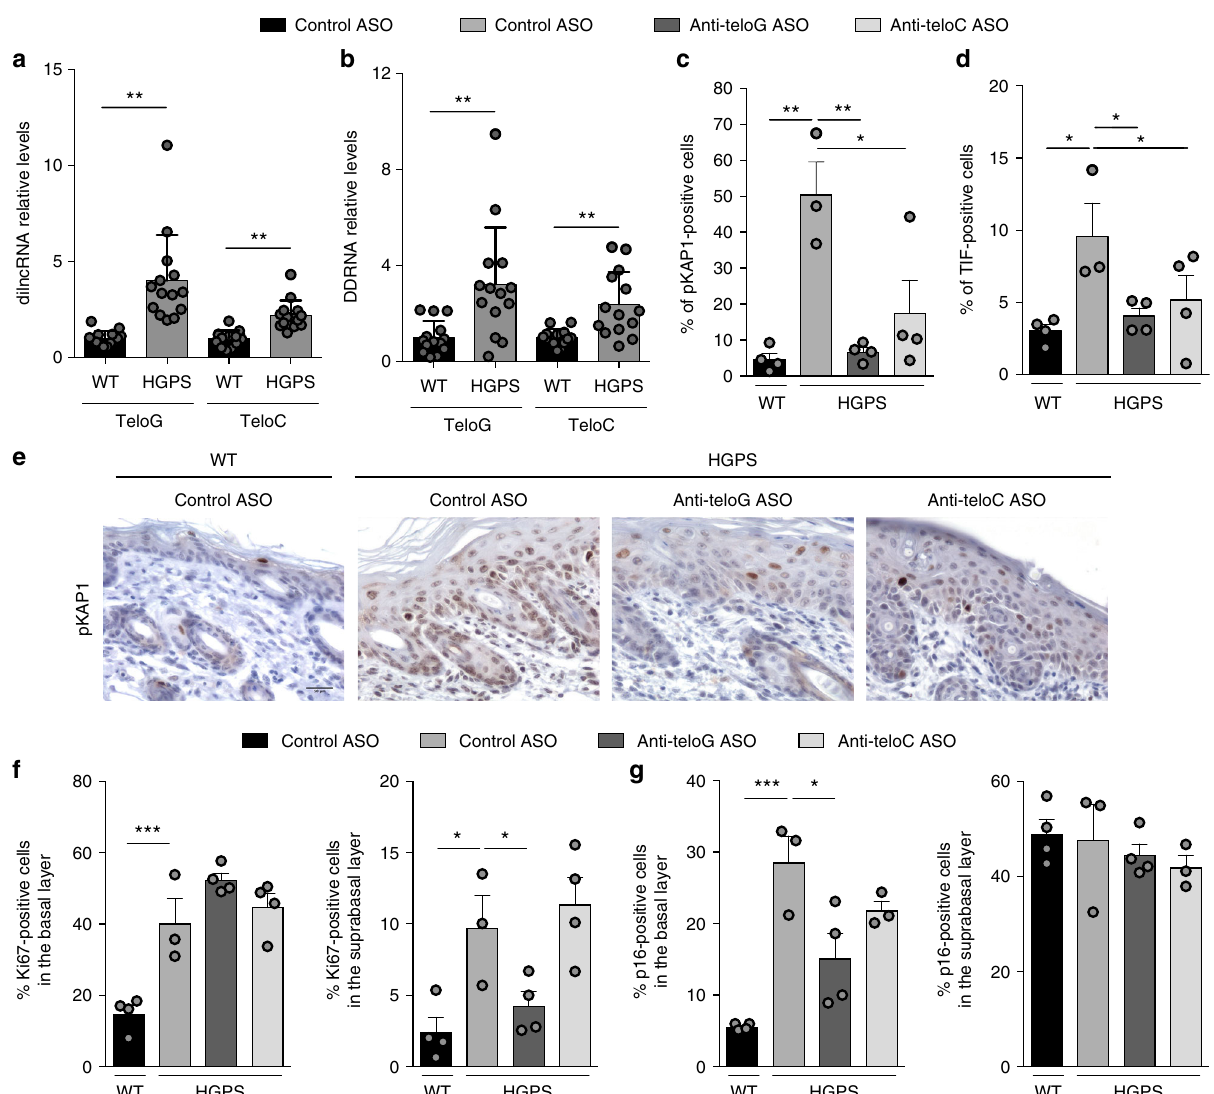
Fig. 3 A mouse skin model of HGPS shows increased levels of tncRNAs and their inhibition in vivo reduces DDR activation and cellular senescence. a , b Total cell RNA was isolated from the skin of wild type (WT) and HGPS mice at post natal days 3 to 8. a tdilncRNAs were quanti fi ed by strand-speci fi c RT-qPCR. Error bars represent the s.d. n = 14 mice per group. ** P < 0.01; two-tailed Student ’ s t test. b tDDRNAs were quanti fi ed by miScript PCR ampli fi cation of gel-extracted small RNAs (shorter than 40 nucleotides). Error bars represent the s.d. n = 14 mice per group. ** P < 0.01; two-tailed Student ’ s t test. c – g Mice subjected to systemic delivery of the indicated ASOs were sacri fi ced at post natal day 6 and skin samples were stained for DDR and proliferation markers. Mouse skin sections were immunohistochemically stained for pKAP1 ( c , e ) and positive cells were quanti fi ed in the epidermis. Scale bar, 50 μ m. d Mouse skin sections were stained for pKAP1 and TRF1 to quantify telomere dysfunction-induced foci (TIFs) as determined by pKAP1 co- localizing with TRF1 in the basal layer of the skin. A cell was counted as positive if showing at least one TIF. n = 3 independent experiments. ** P < 0.01; one- way ANOVA with multiple-comparison post-hoc corrections. At least 300 cells per sample were analyzed. Quanti fi cation of Ki67 ( f ) and p16 ( g ) positive cells in the supra basal and basal layers of epidermis. Error bars represent the s.d. n = 3 – 4 mice per group. * P < 0.05, ** P < 0.01, *** P < 0.001; one-way ANOVA with multiple-comparison post-hoc corrections. At least 300 cells per sample were analyzed. Source data are provided as a Source Data fi